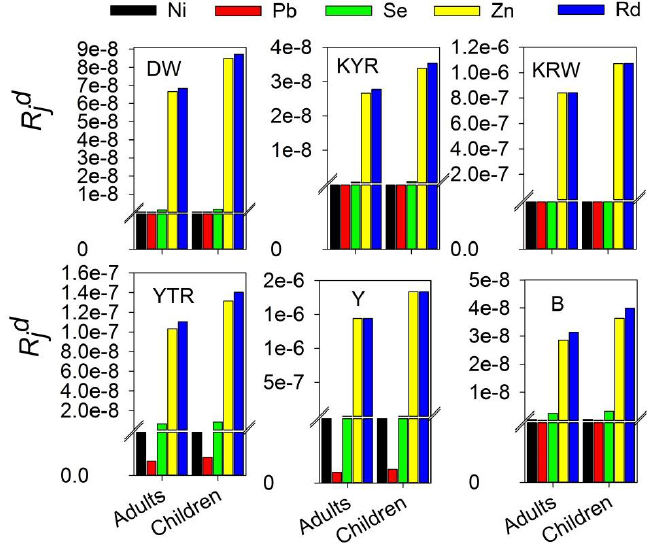
Figure 4. The value of the human health risk assessment induced by non-carcinogenic chemical pollutants of the different regions of Bay County. KYR: Keyir, KRW: Kariwak, YTR: Yatur, DW: Dawanqi, Y: Yangchang, B: Bulong.